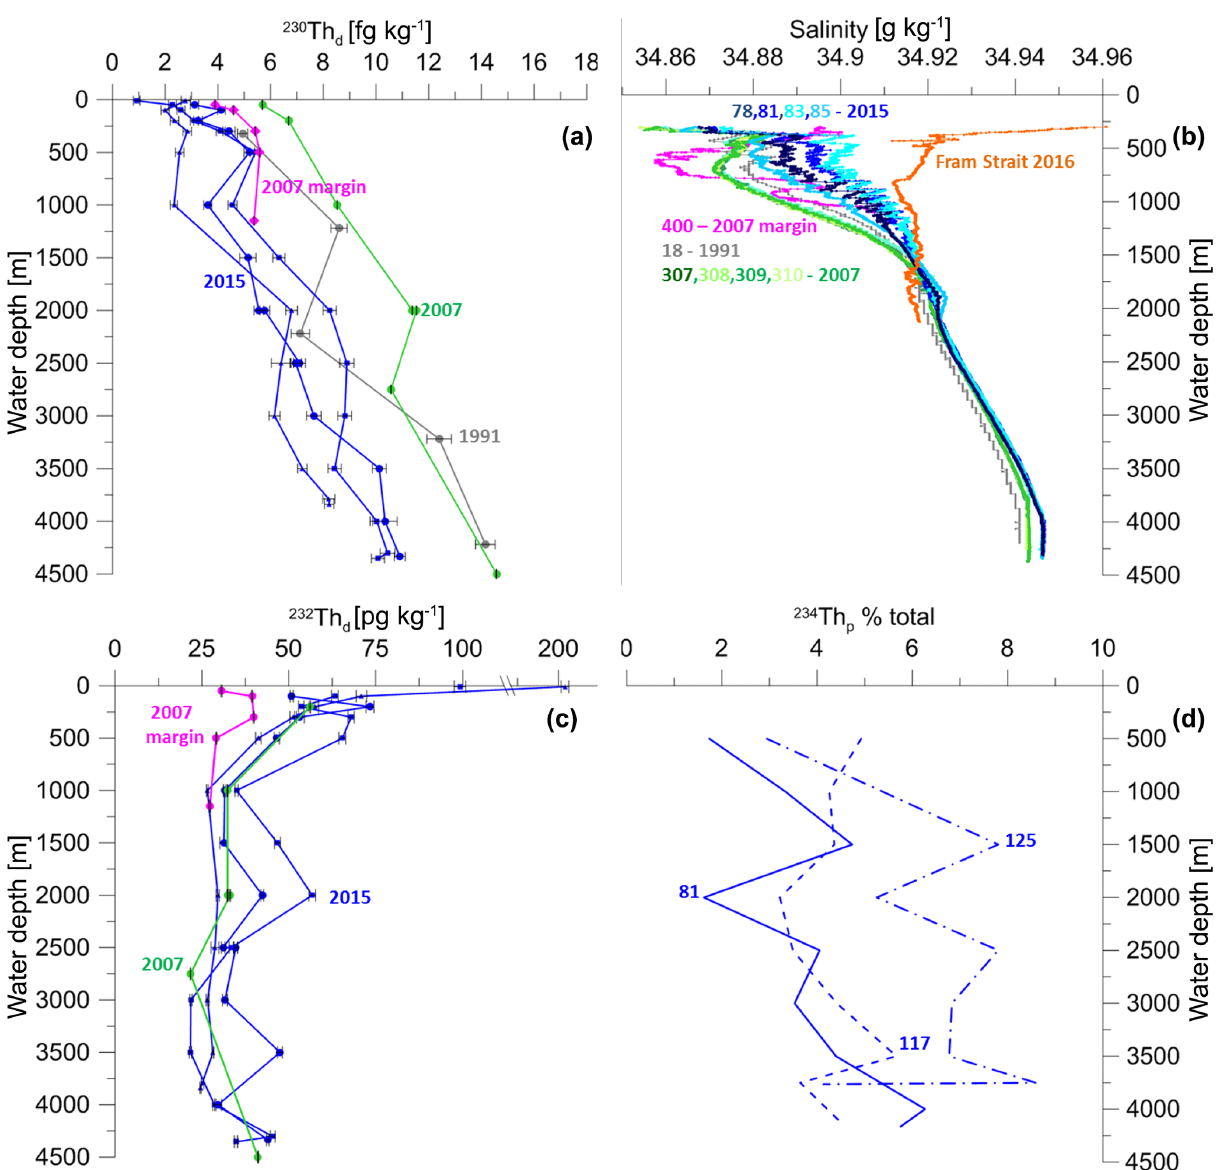
Figure 2. (a) Amundsen Basin dissolved 230 Th from 2015 in blue (81: dots; 117: squares; 125: triangles; same as symbols in Fig. 2a and c), 2007 in green (309), 2007 margin in pink and 1991 in grey (173). (b) Amundsen Basin salinity profiles from 2015 (Rabe et al., 2016), 2007 (Schauer and Wisotzki, 2010) and 1991 (Rudels, 2010) and Fram Strait from 2016 (Kanzow et al., 2017). (c) Dissolved 232 Th from 2015 (81 = dashed, 117 = dashed dotted, 125 = solid), 2007 (309 = green), and 2007 margin (400 = pink) and (d) particulate 234 Th from 2015 in percent of total 234 Th (81: dashed; 117: dashed–dotted; 125: